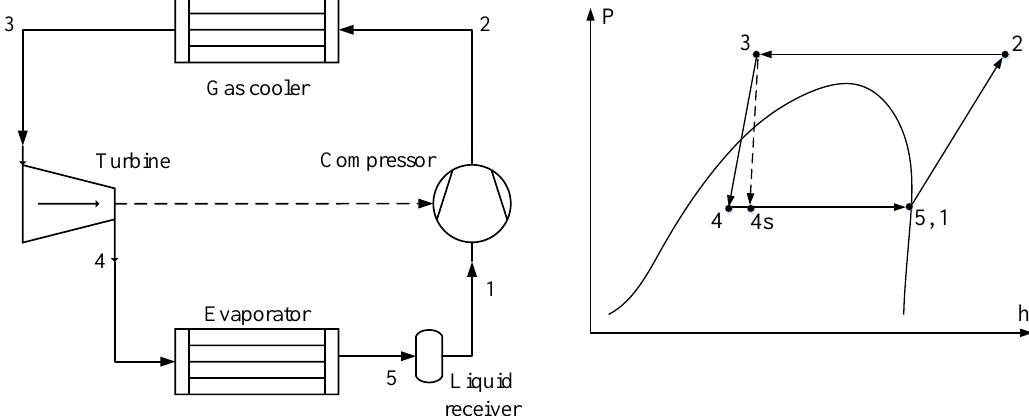
Figure 3. Schematic diagram of the transcritical CO 2 cycle with a turbine (model 3: turbine cycle).